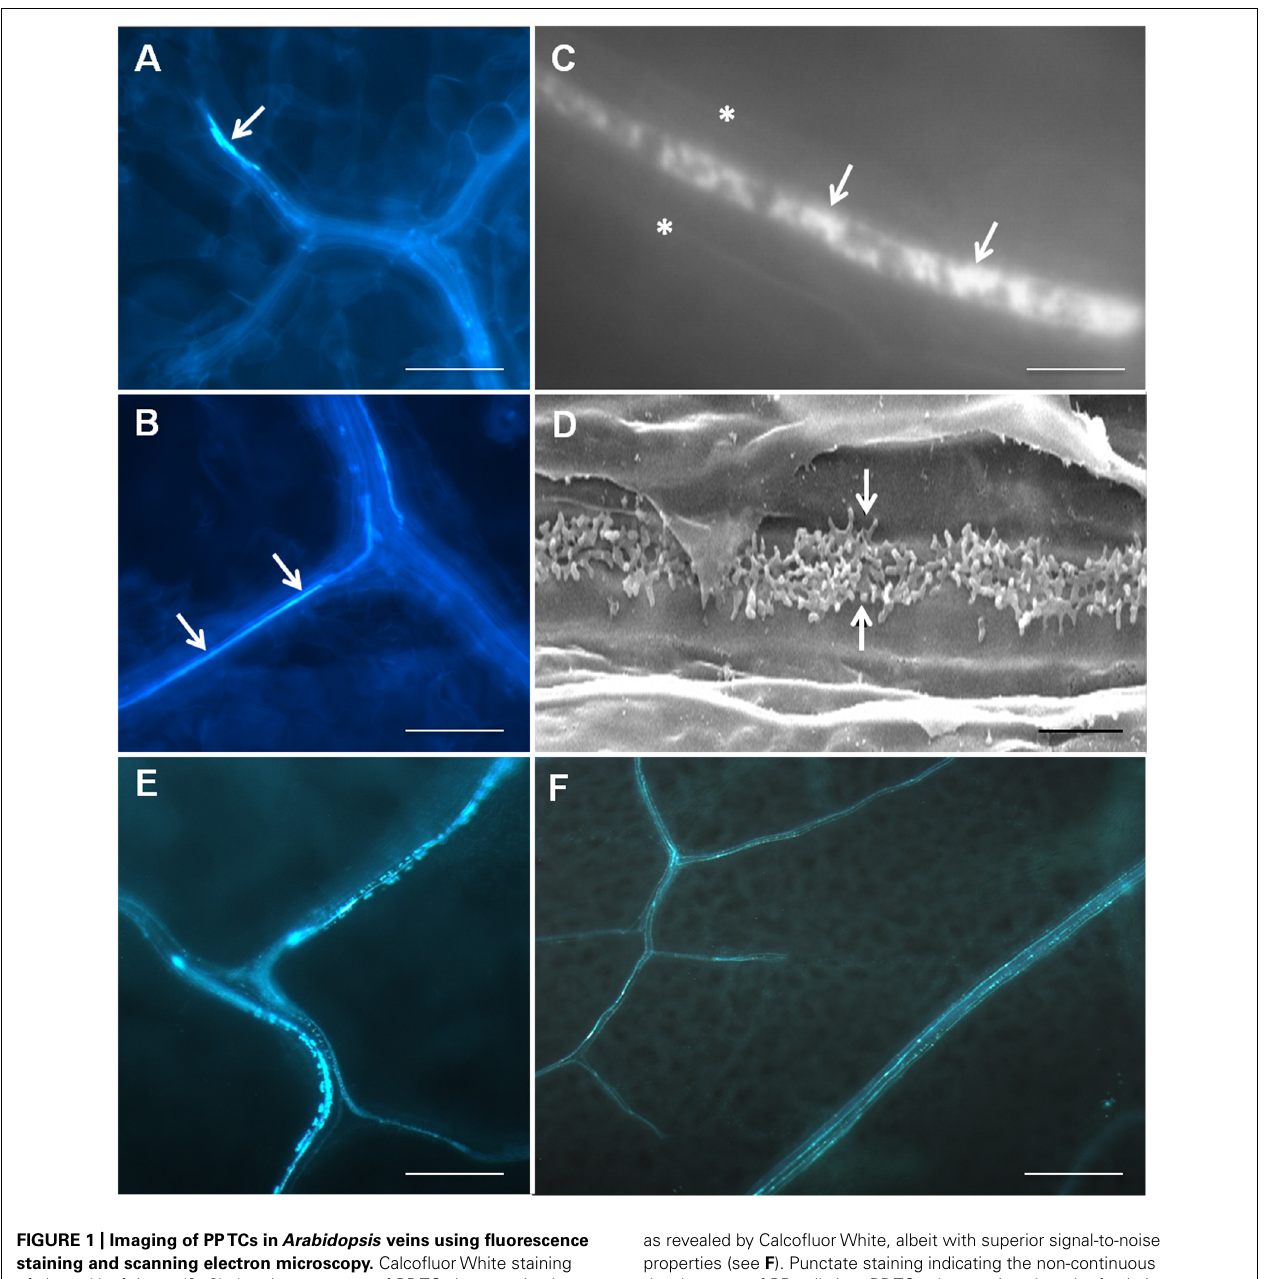
FIGURE 1 | Imaging of PPTCs in Arabidopsis veins using fluorescence staining and scanning electron microscopy. CalcofluorWhite staining of cleared leaf tissue ( A – C ) showing presence of PPTCs in a terminating minor vein (arrow in A ) and as more continuous linear strands of staining running along major veins (arrows in B ). Higher magnification reveals a central band of mottled fluorescence (arrows in C , asterisks mark cell edges) in a PPTC which corresponds to the deposition pattern of reticulate wall ingrowths seen by scanning electron microscopy in these cells (arrows in D ). Staining of PPTCs by aniline blue ( E, F ) shows the same patterns of staining